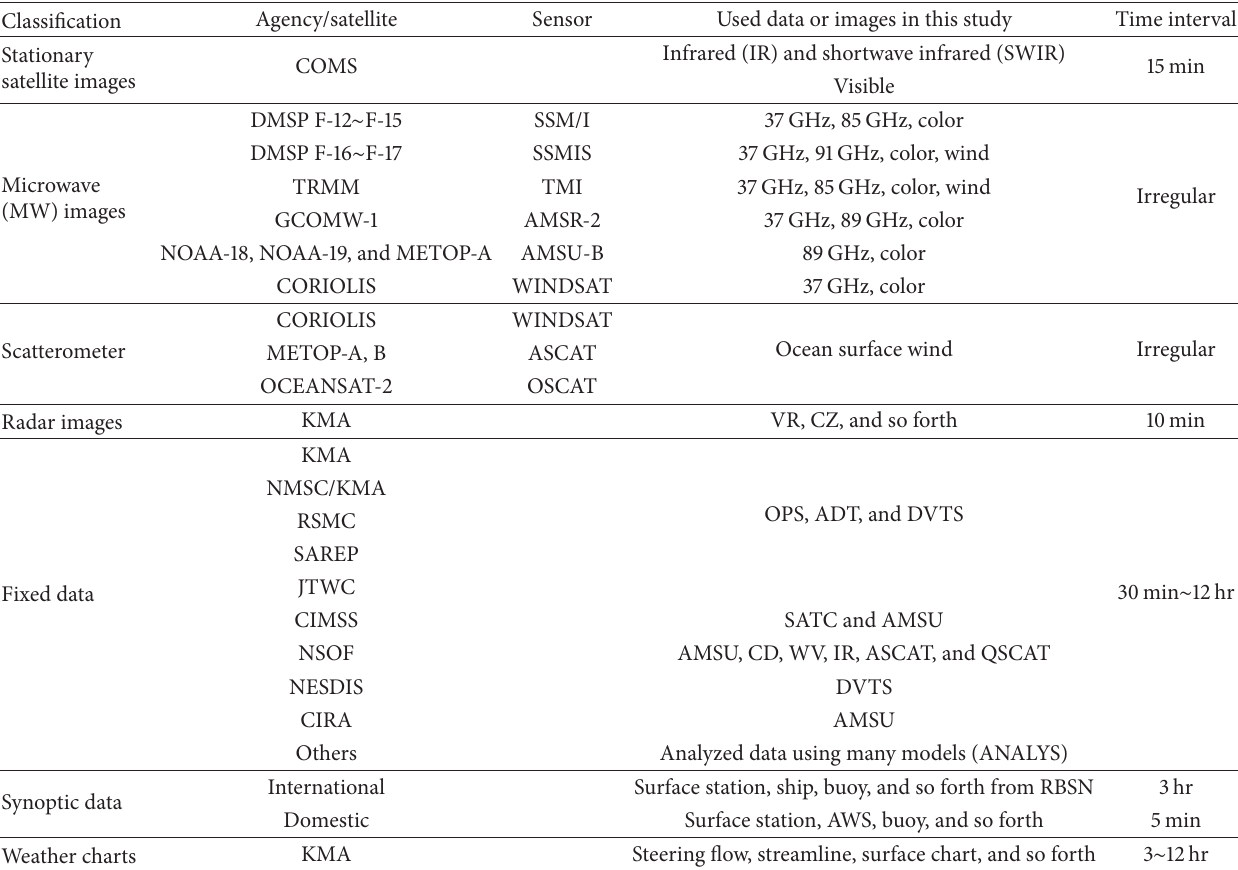
Table 1: List of data used for TC center positioning in this study.